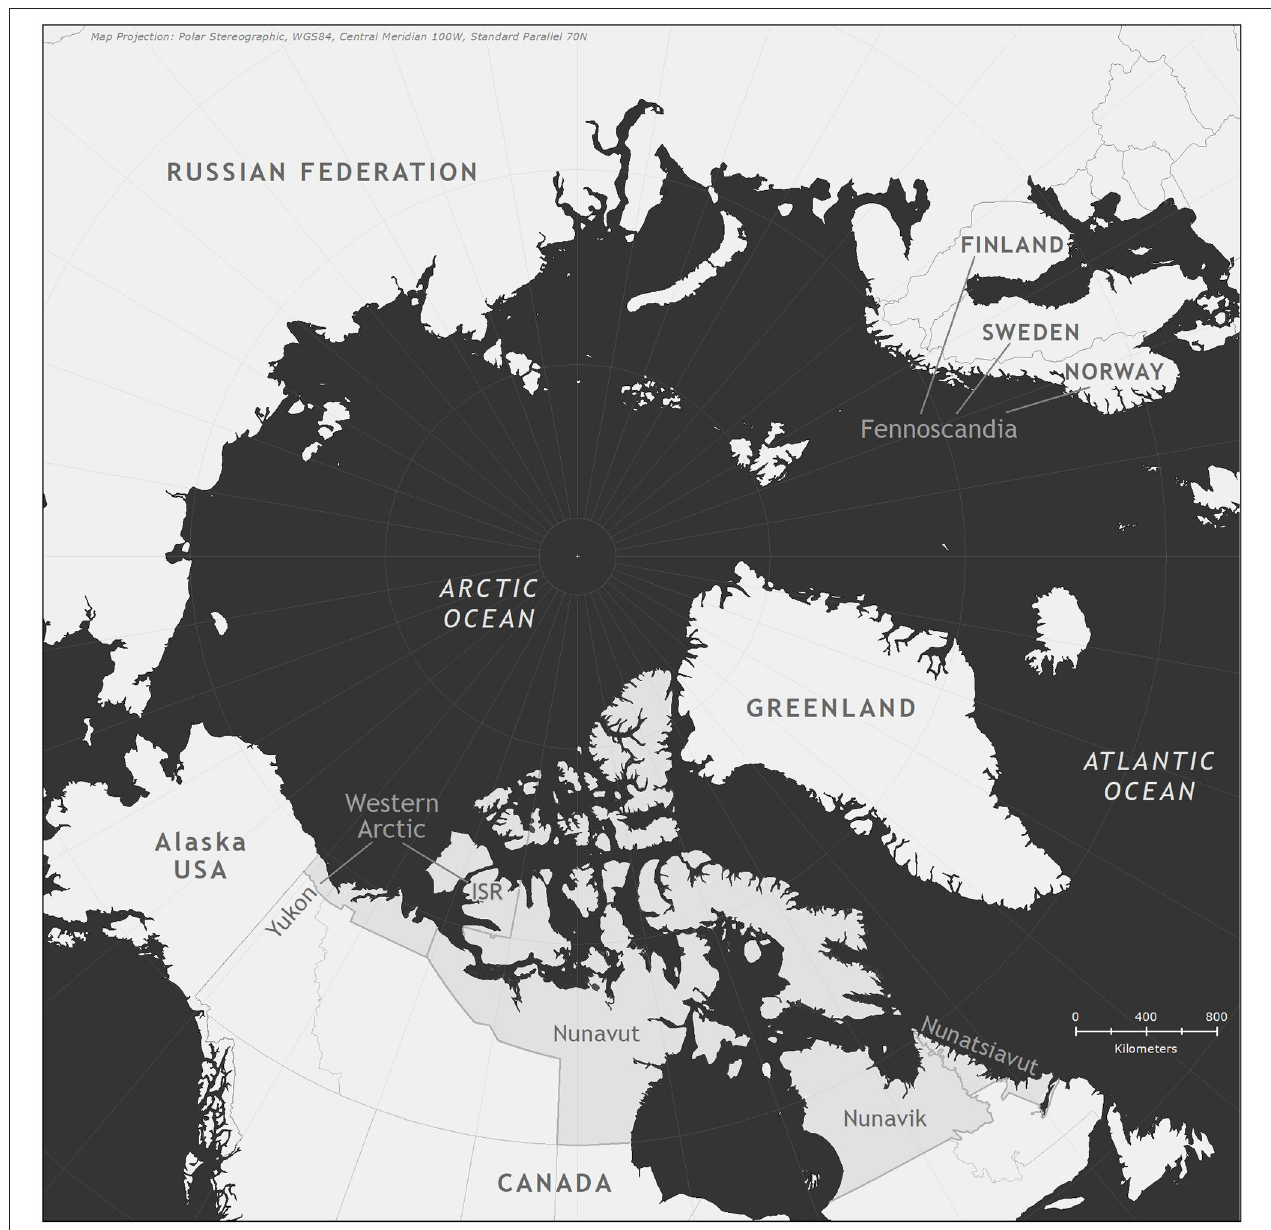
FIGURE 1 | Map of the Arctic showing countries and regions considered in this paper. ISR, Inuvialuit Settlement Region, included in “Western Arctic” for our purposes.